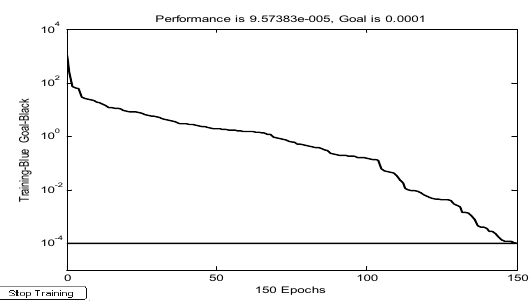
Fig. 5(b) shows the results of frequency SVM with the values of frequency equal to 1350 Hz.